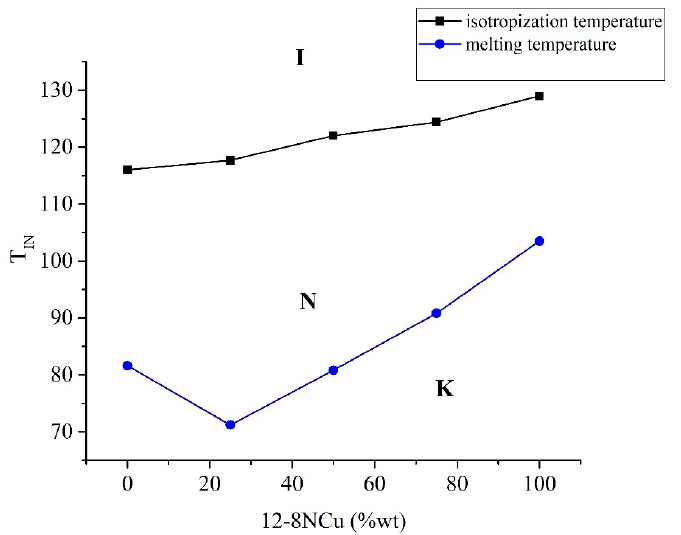
Figure 6. Binary phase diagram for 12-8NCu/A6O-8NCu blends. K indicates the stability field of the crystalline solid phase, N that of the nematic phase and I the isotropic phase.